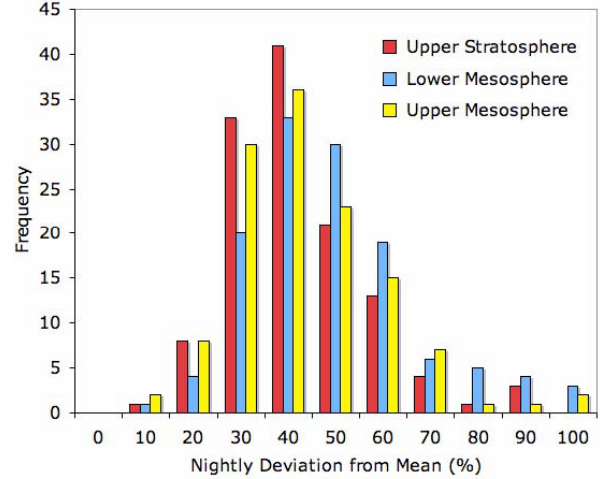
Fig. 7. Histogram of the nightly deviation of the mean-kinetic- energy density for the upper stratosphere (30 to 50km), lower meso- Figure 7. Histogram of the nightly deviation of the mean-kinetic-energy density for the upper sphere (45 to 65km) and upper mesosphere (60 to 80km). Typical stratosphere (30 to 50 km), lower mesosphere (45 to 65 km) and upper mesosphere (60 to 80 variability of the kinetic energy density over a night is about 50% km). Typical variability of the kinetic energy density over a night is about 50% in both the upper in both the upper stratosphere and stratosphere and mesosphere.